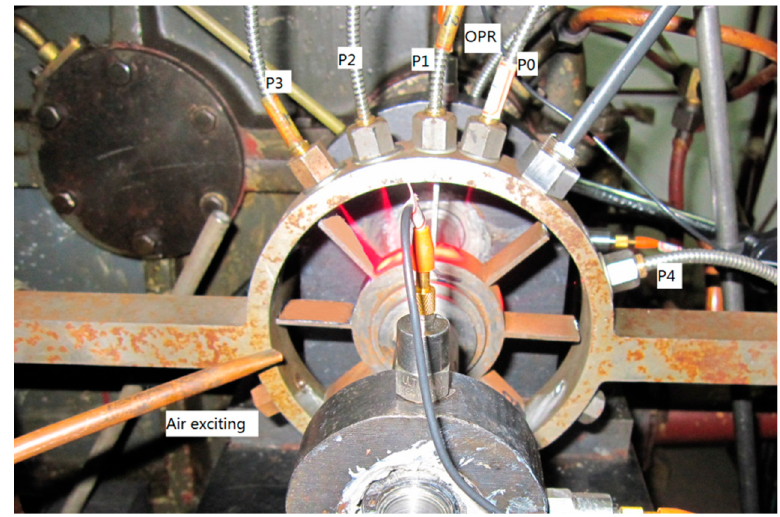
Figure 4. Test rig and installation of fiber optical tip timing sensors.